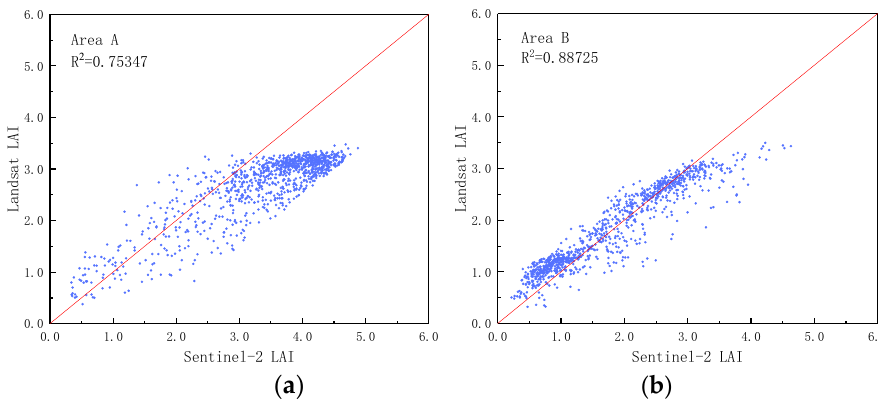
Figure 5. The scatter plots of Landsat LAI inversion and Sentinel-2A LAI for different sites. ( a ) Area A; ( b ) Area B. (red line is the 1:1 line).